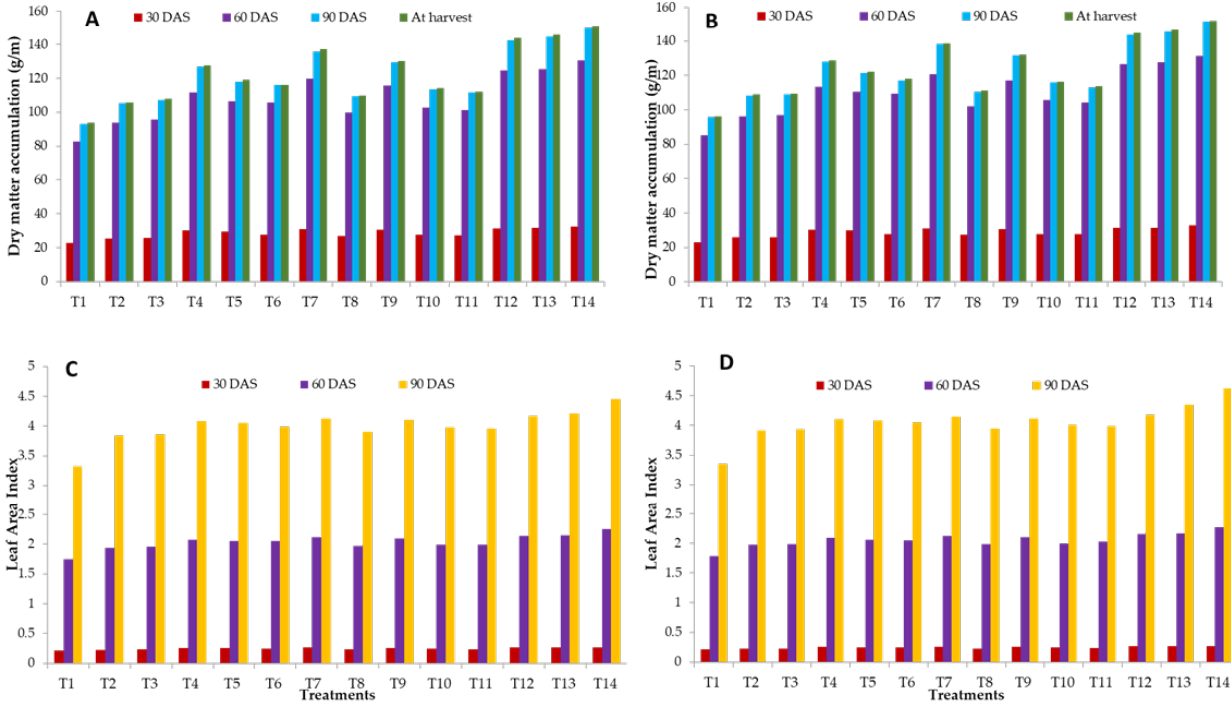
Figure 5. Dry matter accumulation (g/m) during 2017 – 2018 ( A ) and 2018 – 2019 ( B ), and leaf area index (no m −1 row length) during 2017 – 2018 ( C ) and 2017 – 2018 ( D ).